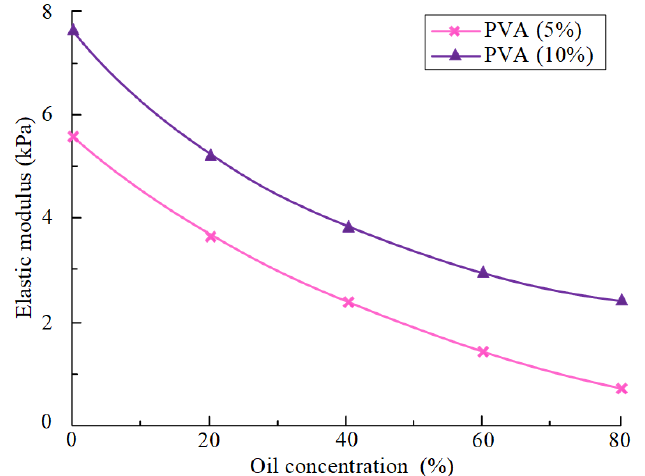
Figure 8. Elastic modulus of fuel pellets of oil-filled cryogels vs. oil concentration at various concentrations of aqueous solution of PVA.